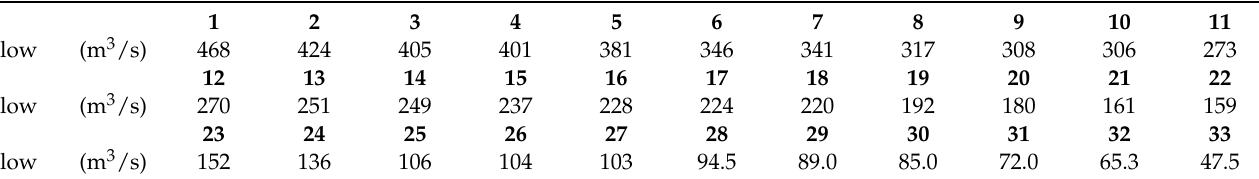
Table 5. The observed data from the Tandarei hydrometric